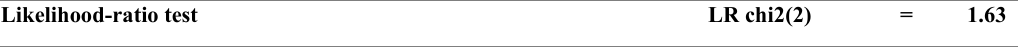
Table 8: LR test on the effect of empathy as level-2 random covariate Likelihood-ratio